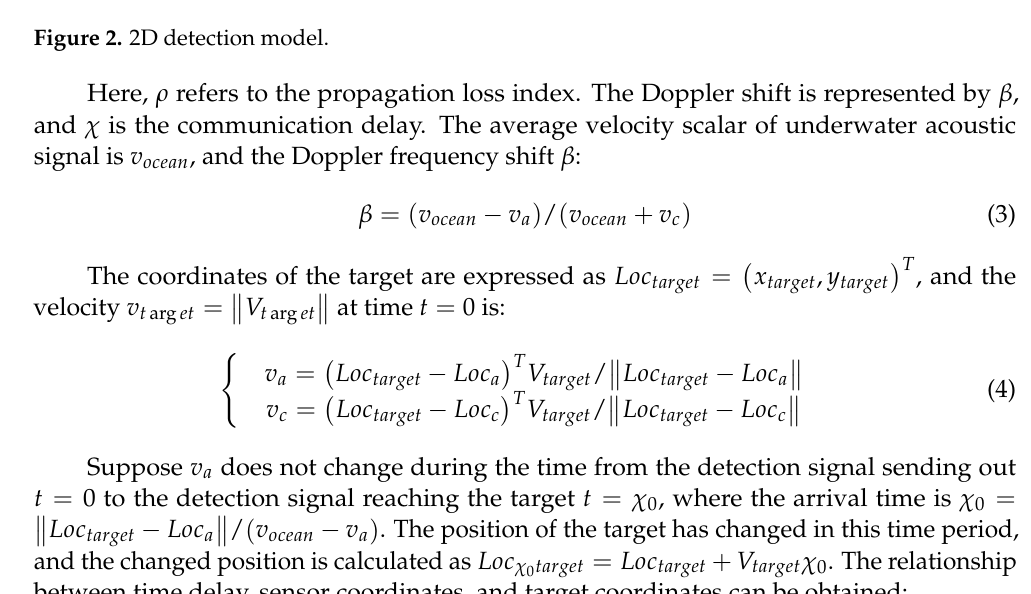
Figure 2. 2D detection model